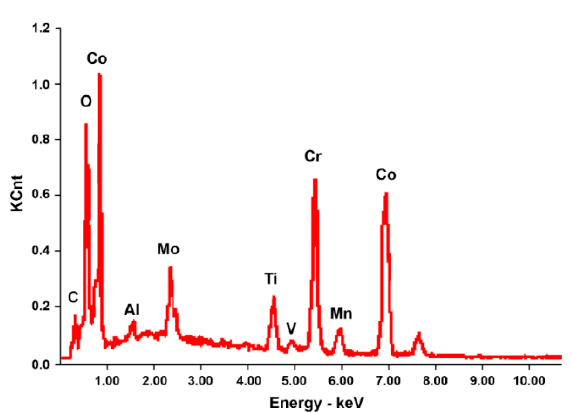
Figure 4. X-ray energy spectrum for the elemental analysis of sample P3.